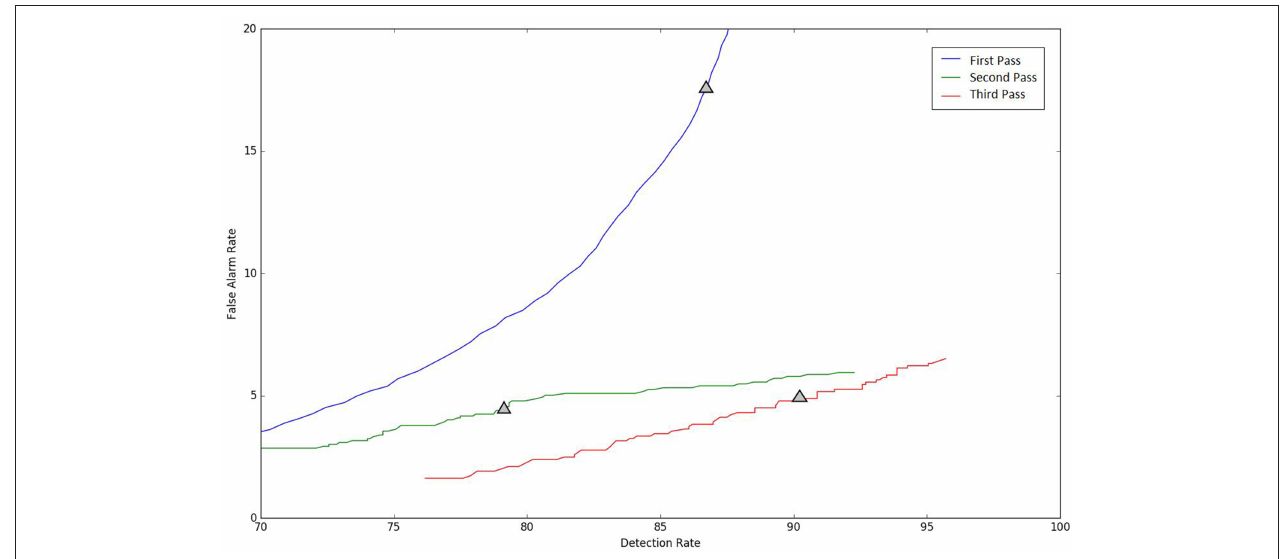
FIGURE 8 | DET curves are shown for each pass of processing. The “zero penalty” operating point is also shown since this was used in Tables 3 – 5 .